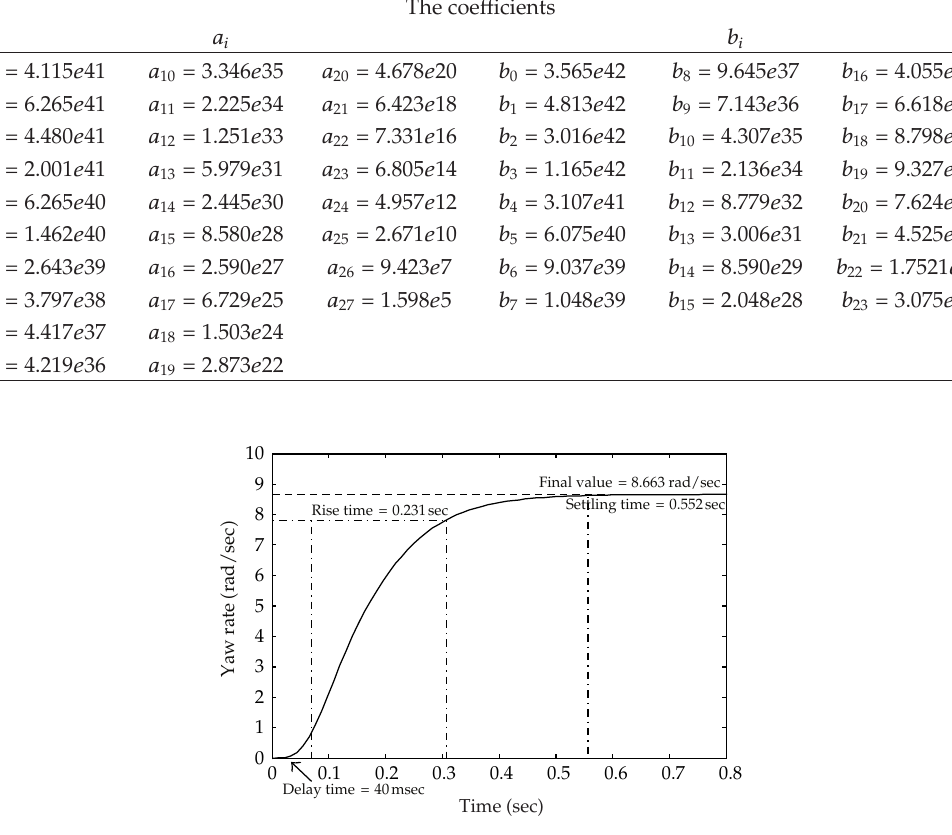
Figure 12: Original system